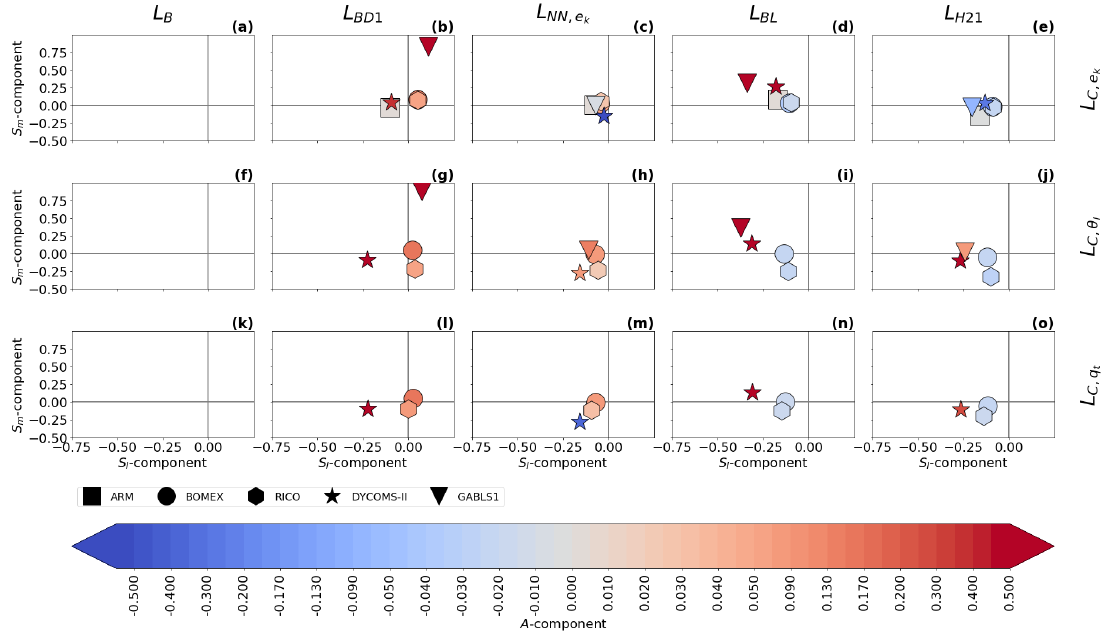
Figure 10. Same content as Figure 9 but for the second smallest sub-domain size ( N sd = 16 2